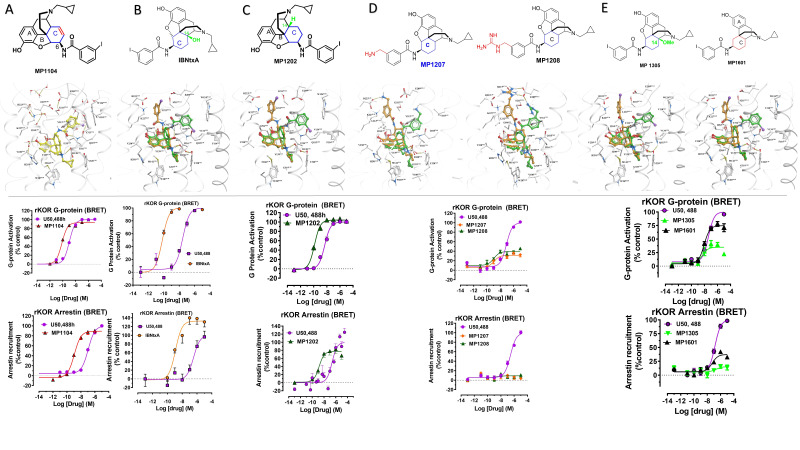
Characterization of ligands (MP1104, IBNtxA, MP1202, MP1207, MP1208, MP1305 and MP1601) at rat kappa opioid receptor (rKOR) using BRET assays-chemical structures, docking in MOR, G protein activity, and arrestin recruitment.
A) MP1104 targets the TM2-TM3 region and is arrestin biased at rKOR: The preferred docking pose of MP1104 (boat form, yellow stick) at an active state of KOR is shown. The iodophenylamido moiety aligns in the hydrophobic pocket between TM2 and TM3 in KOR, a cavity lined with V1182.63, W124ECL1, and L1353.29. In addition, polar residue Q1152.60 adopts a slightly different conformation which allows more room for the hydrophobic moiety. Such increase in hydrophobic nature of the KOR binding pocket may well be associated yielding the best docking scores of MP1104 in its boat conformation. MP1104 (red) is a full agonist in rKOR in BRET assays measuring G protein activation (N = 6) and arrestin recruitment (N = 6) compared to U50,488H (purple). (B) IBNtxA prefers the boat form at KOR and is not biased for any pathway at mKOR: The docking poses of IBNtxA (chair form, orange stick) and (boat form, green stick) at an active state of KOR are shown. At rKOR, the iodophenylamido moiety of IBNtxA aligns in the hydrophobic pocket between TM2 and TM3 in KOR, a cavity lined with V1182.63, W124ECL1 and L1353.29. In BRET assays using rKOR, IBNtxA is a full agonist for G protein (N = 3) as well as Arrestin signaling (N = 3) compared with U50,488H (purple). (C) MP1202 prefers the boat form at KOR and is not biased for any pathway at rKOR. The preferred docking pose of MP1104 (boat form, yellow stick) and MP1202 (chair form, orange stick) at an active state of KOR. The iodophenylamido moiety aligns in the hydrophobic pocket between TM2 and TM3 in KOR, a cavity lined with V1182.63, W124ECL1, and L1353.29. In addition, polar residue Q1152.60 adopts a slightly different conformation allowing more room for the hydrophobic moiety. Such increase in hydrophobic nature of the KOR binding pocket may well be associated yielding the best docking scores of both MP1104, IBNtxA and MP1202 with their boat conformation. MP1202 (green) is a full agonist in rKOR measuring G protein activation (N = 3) and arrestin recruitment (N = 9) compared to U50,488H (purple) in BRET assays. (D) m-Aminomethyl (MP1207) and m-guanidinomethyl (MP1208) analogs prefer the chair conformation and target the TM5-ECL2 region and show no arrestin recruitment at KOR. Docking results showed that m-amino methyl (MP1207) or m-guanidinomethyl (MP1208) moieties (replacing an iodo group in MP1202) forced these compounds in chair form preferred confirmation at KOR (chair form in orange stick and boat form in green stick). Unlike boat MP1202, chair MP1207 at KOR may form a new salt bridge interaction between amino group and D2235.35 and E209A pulling the amidophenyl moiety away from the hydrophobic pocket between TM2 and TM3. Likewise, chair MP1208 forms salt bridge interactions between guanidino group and D2235.35 as well as with E209ECL2.
MP1207 (orange) and MP1208 (green) are partial agonists for G-signaling (N = 3) at rKOR in BRET assays compared to U50,488H (purple). No arrestin recruitment was observed for both agonists (N = 5) against U50,488H as a control at rKOR. (E) MP1305 showed no arrestin recruitment and MP1601 was not biased for any pathway at rKOR: Chair and boat forms of MP130) and MP1601 at an active state KOR (in gray) are shown. Both MP1305 (green) and MP1601 (black) are partial agonists for G-signaling (N = 3) at rKOR in BRET assays compared to U50,488H (blue). No arrestin recruitment was observed for MP1305 (N = 6) while MP1601 was a partial agonist for arrestin signaling pathway (N = 6). In summary, targeting TM5-ECL2 and ring C taking chair form leads to preference for G protein pathway at KOR in both rodents as well as human receptors with analogs. See Appendix 1—table 8 for values, Appendix 1—figure 4 and Appendix 1—table 11 for bias calculations.